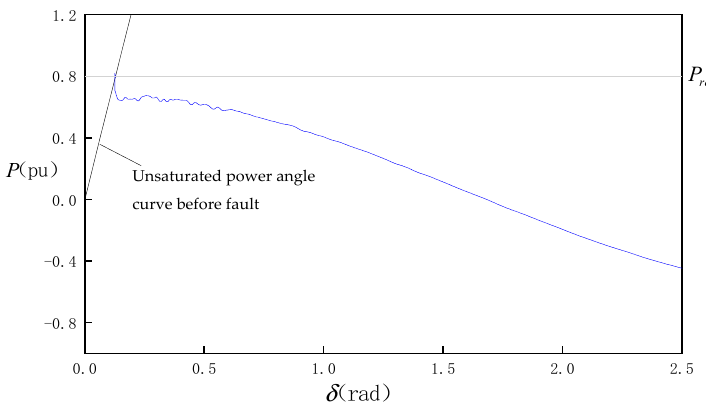
Figure 15. Simulation results of deep voltage sag while X Σ is 0.16 pu.